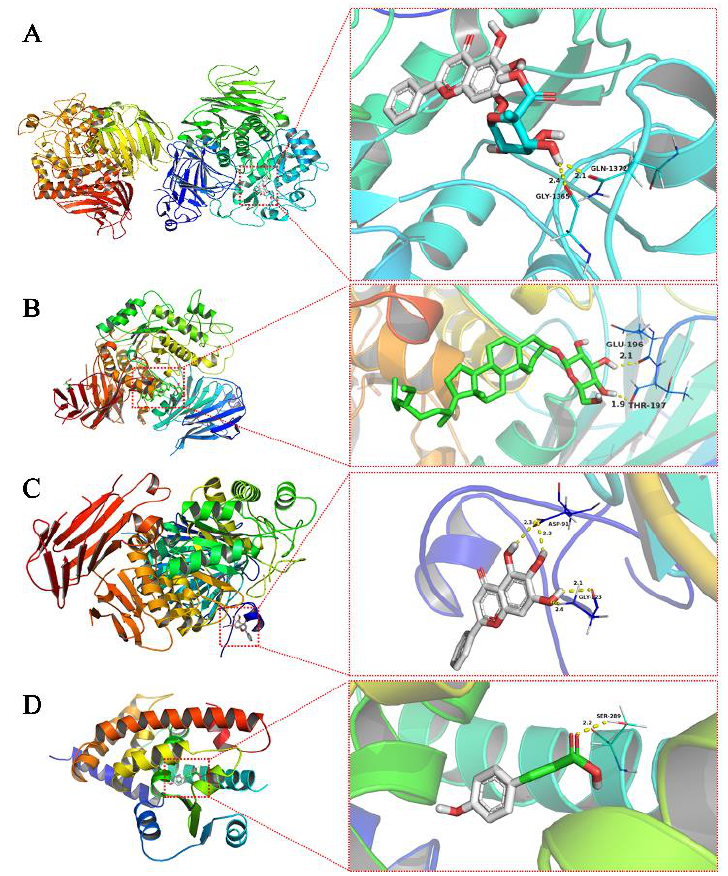
Figure 2. Molecular docking results of baicalin with GMAM ( A ), sitoside with GAA ( B ), baicalein with GAA ( C ) and 4-hydroxycinnamic acid with PPARG ( D ). The structures of proteins are shown using a cartoon model, while the active component is shown using a stick model and amino acid residues are shown using a line model (the number shows the site in the protein). The hydrogen bonds between the active component and amino acid residue are represented in yellow dashed lines, with the number showing the distance (Å).